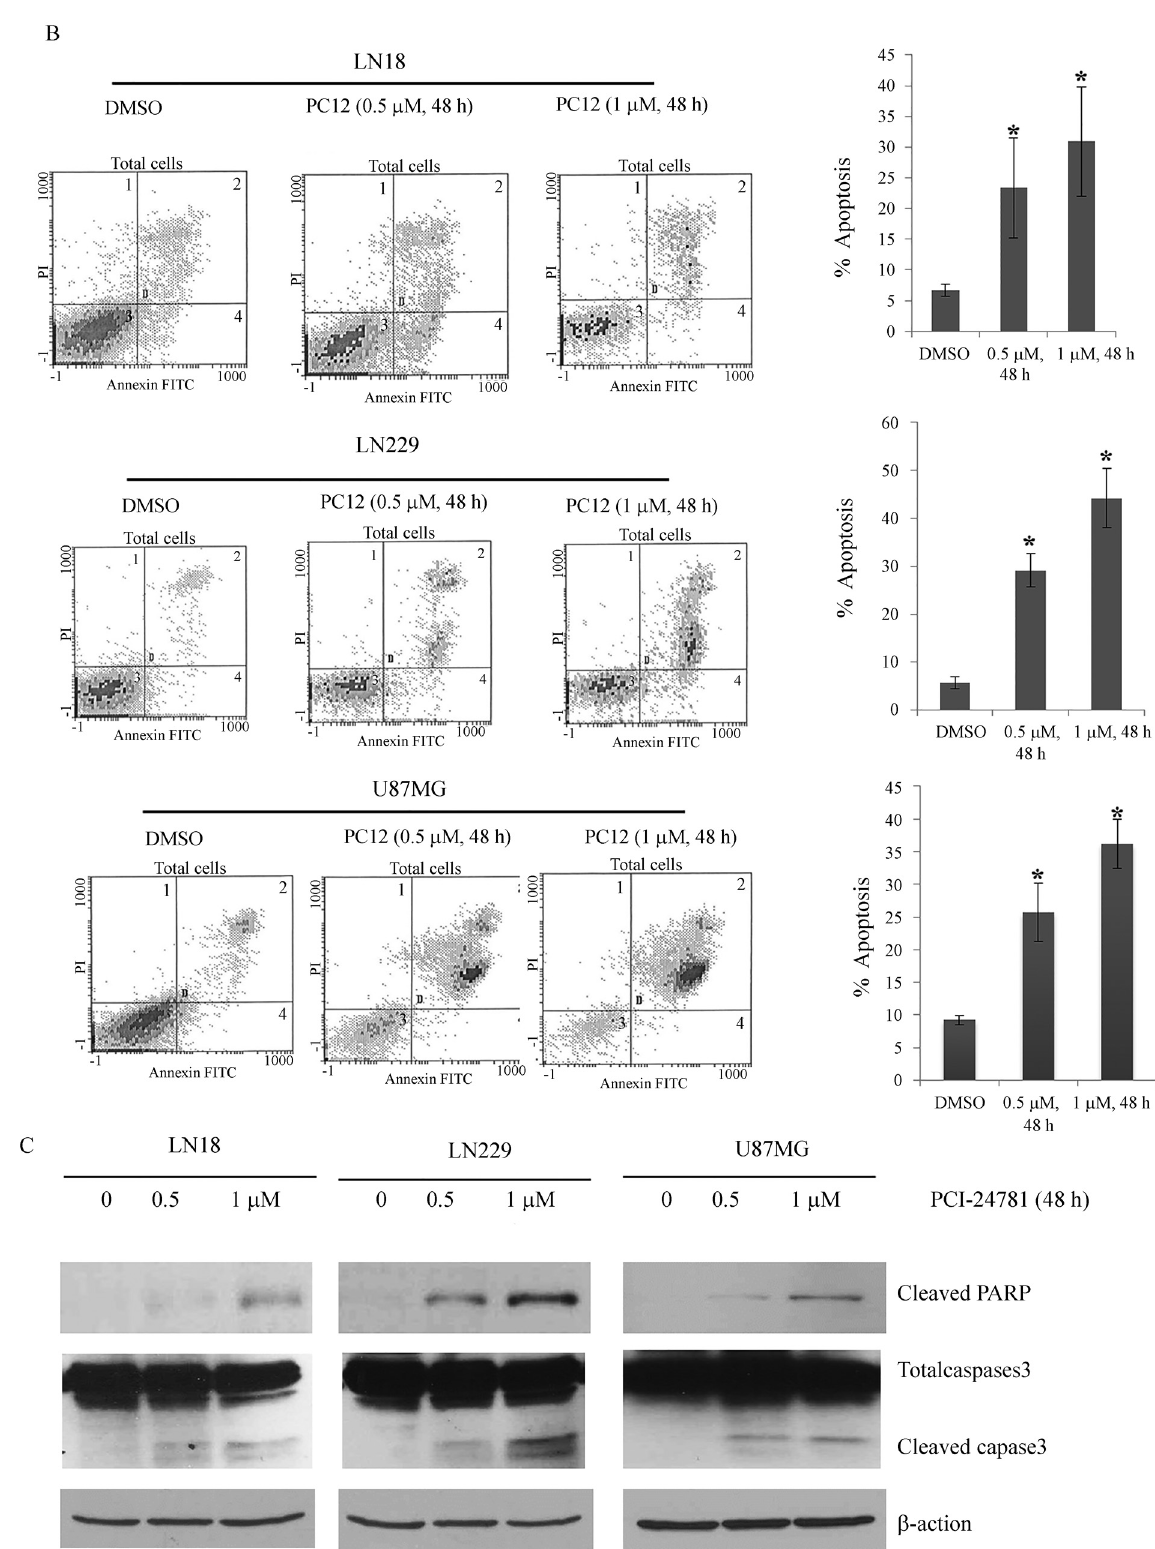
Figure 2 cont. - PCI-24781-induced G2 cell cycle inhibition and apoptosis in malignant glioma cells. Note the concentration-dependent increase in (A) G2/M checkpoint activation and (B) malignant glioma cell apoptosis. (C) PARP and caspase 3 cleavage was detected in three malignant glioma cell lines treated with 0.5 or 1 (cid:2) M PCI-24781. In panels (A) and (C) the columns are the mean (cid:5) SD of 3 determinations. *p < 0.05 compared with the DMSO con-